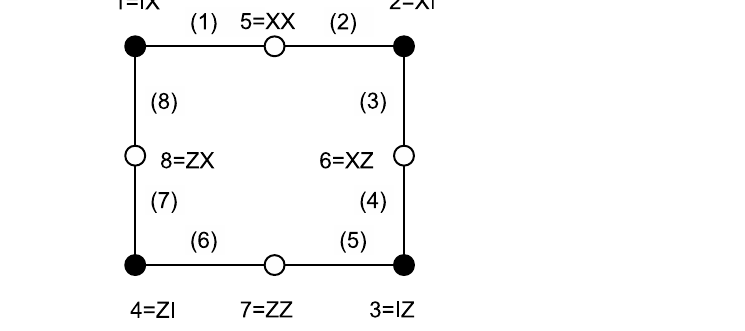
Figure 2. The commutation/anti-commutation diagram for Bell’s theorem is, at the same time, a dessin d’enfant with permutation group P = ⟨ (cid:11); (cid:12) ⟩ = D